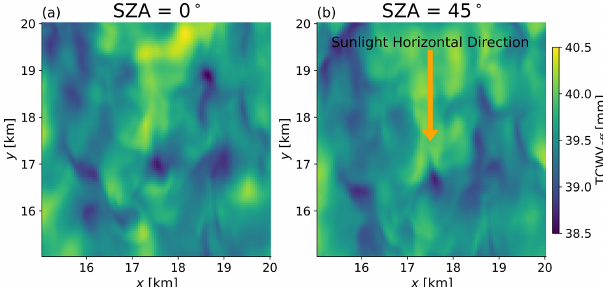
Figure 1. Integrated water path in a subsection of the ARM_18000s snapshot (a) in vertical columns directly over each footprint (i.e. true TCWV) and (b) encountered by sunlight with SZA = 45 ◦ viewed from nadir. The yellow arrow indicates the horizontal di- rection of the downward solar